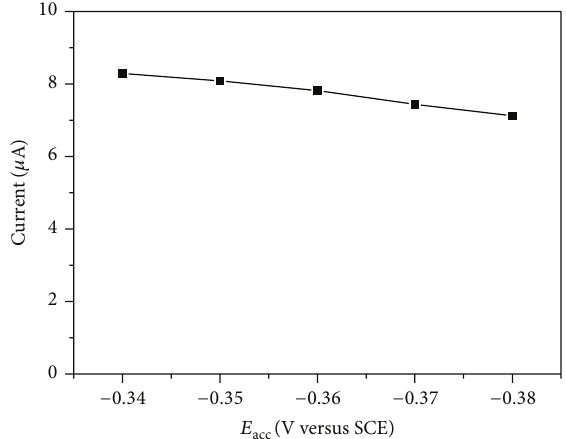
Figure 4: The effect of pH of the supporting electrolyte on the Figure 6: The effect of preconcentration potential on the stripping stripping peak current (a) and the position of peak (b) of Ge(IV)- peak current of Ge(IV)-pyrogallol complex. Other conditions as in pyrogallol complex in 0.1molL −1 HAc-NaAcn + pyrogallol ( 1.3 × Figure 10 −3 molL −1 ) + 3 × 10 −4 molL −1 KBrO 3 ; Ge(IV) concentration: 10 𝜇 gL −1 . Other conditions as in Figure 1.